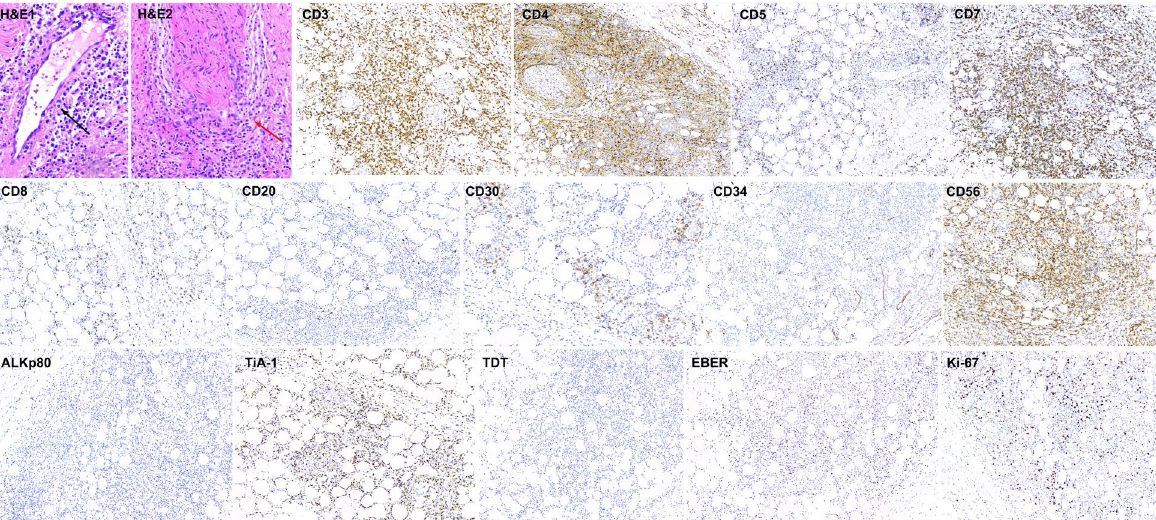
Fig. 3 Immunohistochemical manifestation of the right forearm nodule. H&E stain( lymphocytes with medium-sized cells and visible nuclear fragmentation and fission, in addition to cancer cells invading blood vessels (H&E1, black arrow) and nerves (H&E2, red arrow). Positive for CD3, CD7, CD56 and TiA-1, weakly positive for CD4, 10% positive for CD30 hotspot area( negative for CD5, CD8, CD20, CD34, ALKp80 and TDT, 30% positive for Ki-67, positive for EBER in situ hybridization (except H&E and CD30,